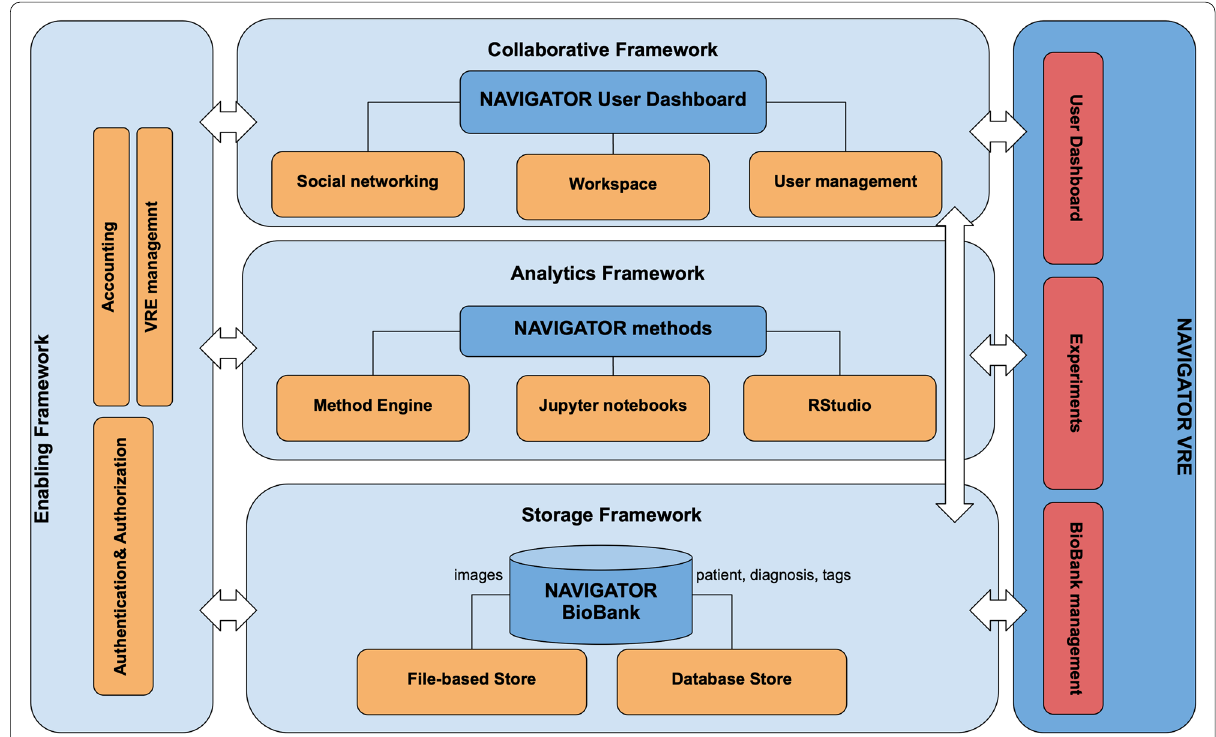
Fig. 2 NAVIGATOR virtual research environment (VRE) instantiated over the D4Science